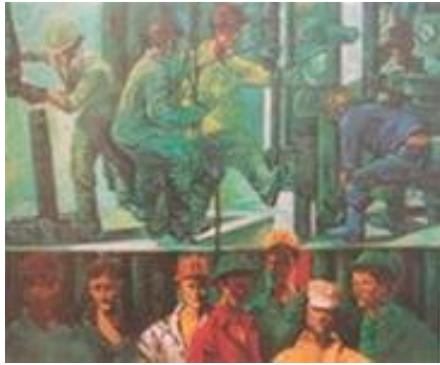
Figure A25. Binh minh tren cong truong —Luong Van Trung painted in 2005. The image was sourced from Tuoi Tre Newspaper (TuoiTre 2005).